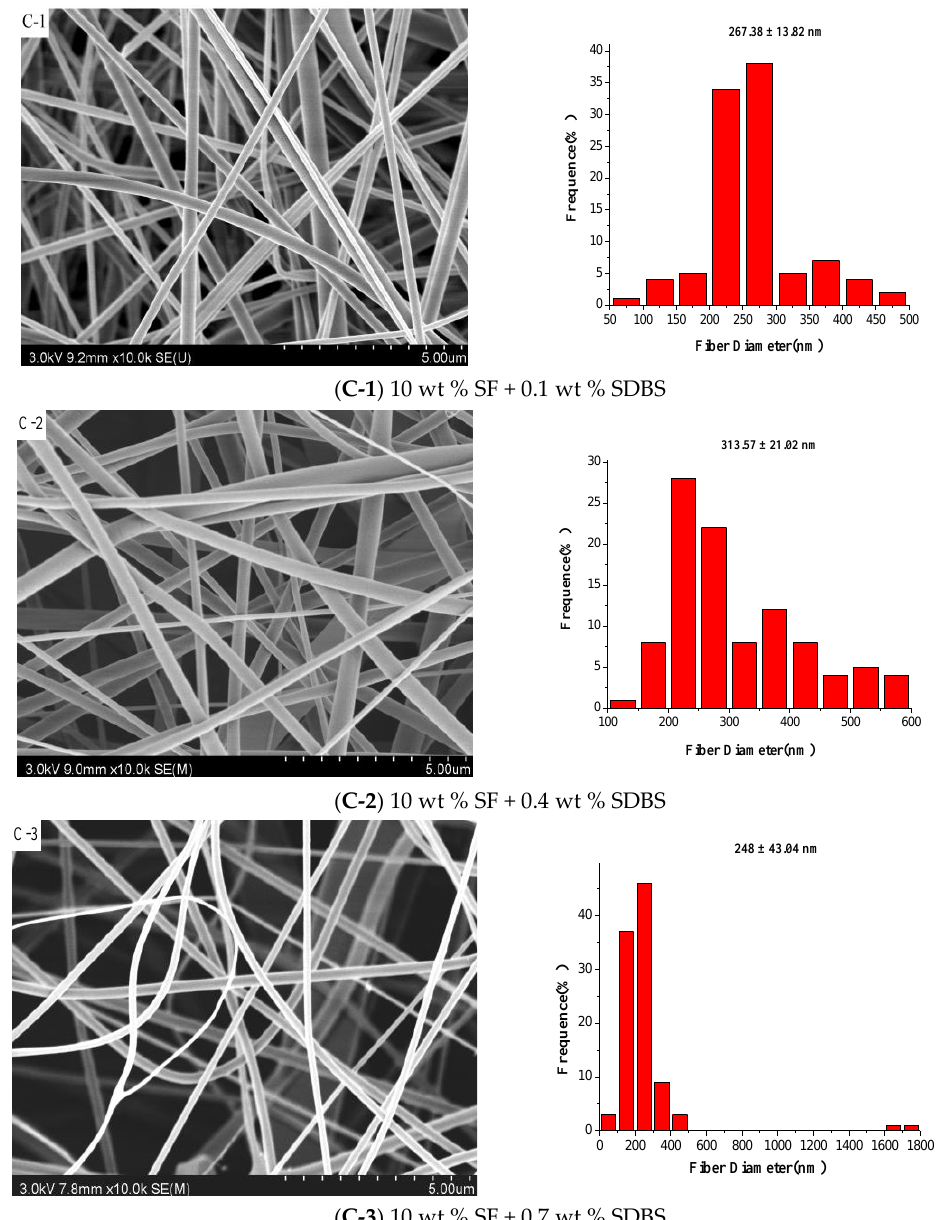
Figure 5. SEM pictures and the according diameter distribution of the SF nanofibers with SF concen- trations of ( A ) 6 wt %; ( B ) 8 wt % and ( C ) 10 wt %, respectively. (Gas flow volume: 150 m 3 /h). Reference 1.